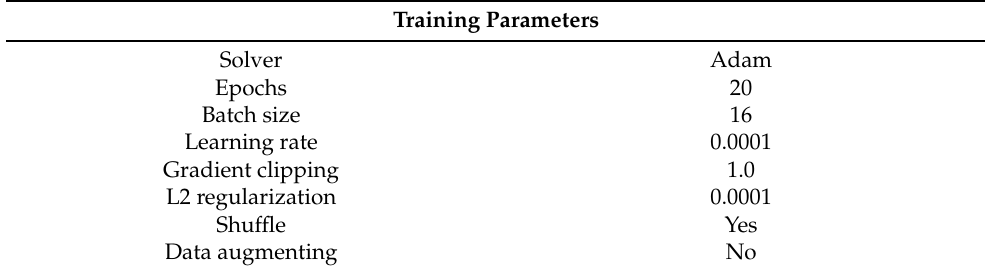
Table 11. Training parameters for UNet on UOPNOA.